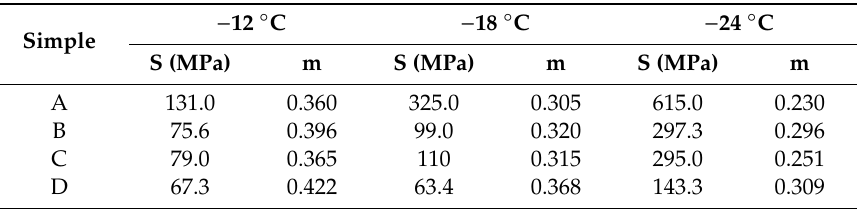
Table 5. Creep sti ff ness modulus S and creep rate m value.